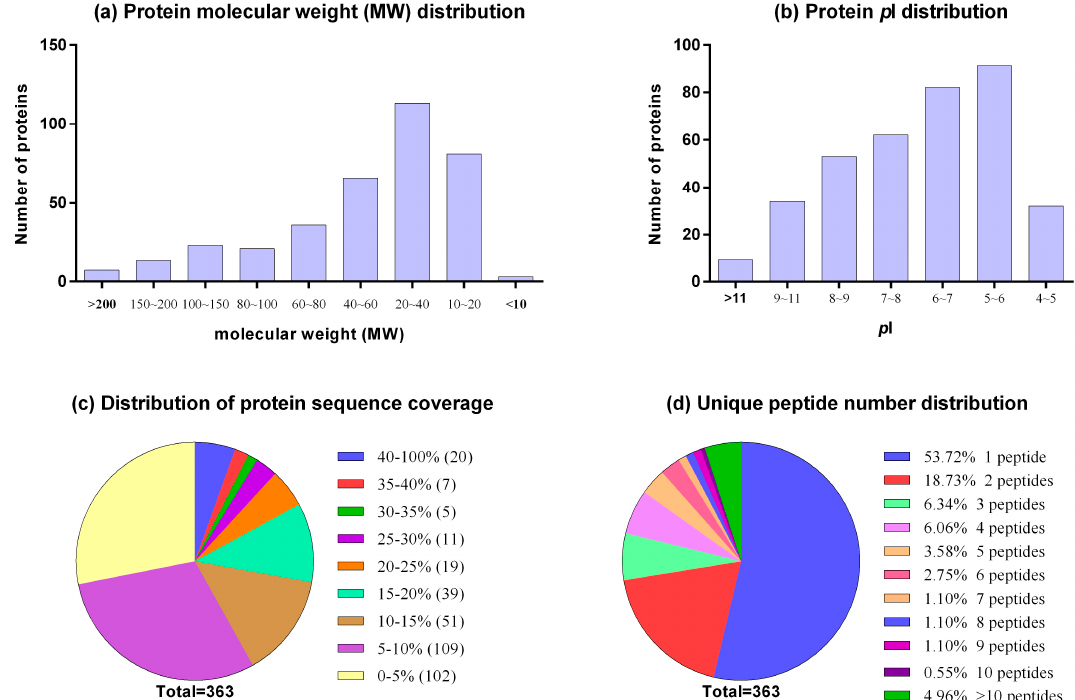
Figure 2. Distribution of the molecular weight, p I, sequence coverage and number of unique peptides of the identified proteins in BFF:( a ) distribution of protein molecular weights; ( b ) distribution of protein p I values; ( c ) distribution of protein sequence coverage; and ( d ) unique peptide number distribution.